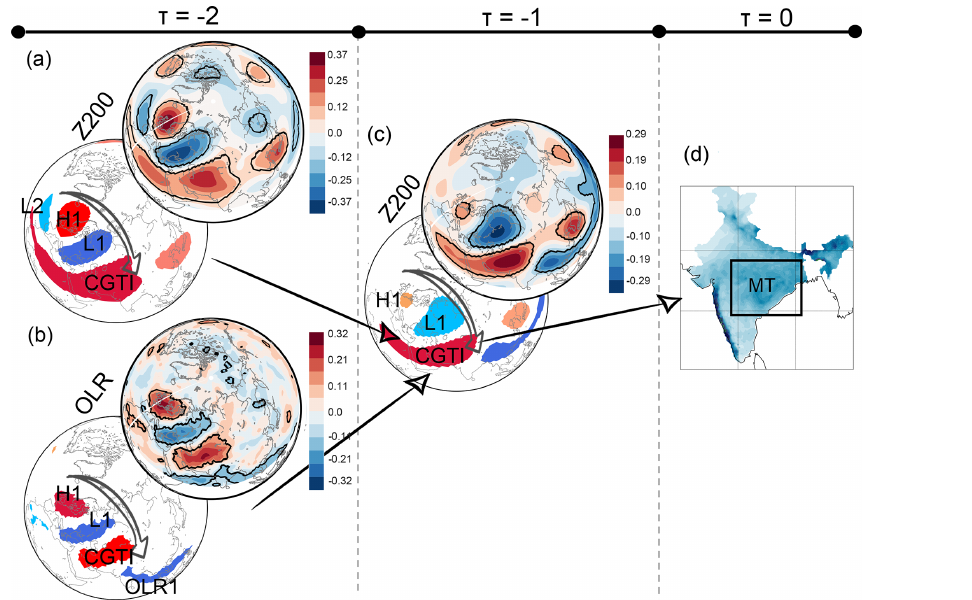
Figure 4. Mid-latitude causal precursors of ISM. (a) Correlation of CGTI with Z200 at 1-week lead time (top) and the causal precursors of CGTI identified via RG-CPD (bottom) for the period 1979–2017. (b) As for panel (a) but for OLR fields. (c) Correlation map for weekly MT rainfall and Z200 field at 1-week lead time (top) and the causal precursors identified via RG-CPD (bottom). (d) ISM rainfall over the MT region from the Pai et al. (2015) dataset (reproduced from Fig. 1a). Regions with correlation values with a p value of p < 0 . 05 (accounting for the effect of serial correlations) are shown by black